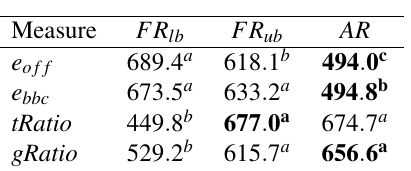
Mean ranks returned by the Kruskal-Wallis test for the global performance of FR lb , FR ub and AR over the MPB problem with eight different number of peaks ( peaks = { 5 , 10 , 20 , 30 , 40 , 50 , 100 , 200 } ). The superscripts of the values provide the same information explained in Table